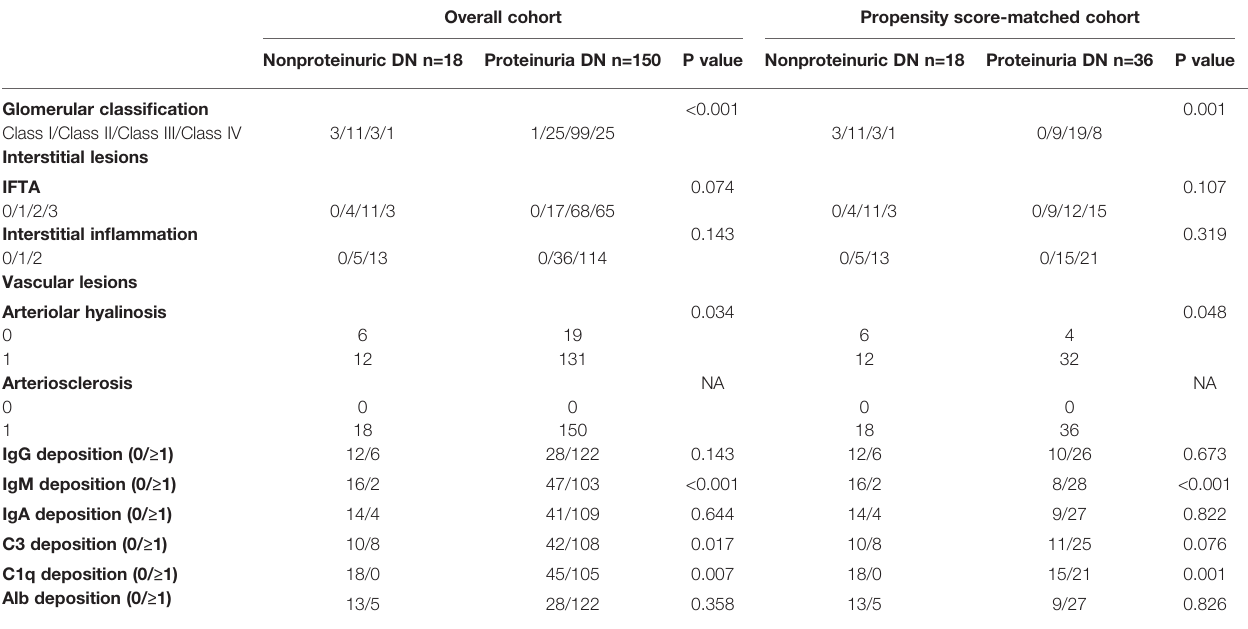
TABLE 3 | Renal histopathological features of patients strati fi ed by proteinuria. Overall cohort Propensity score-matched